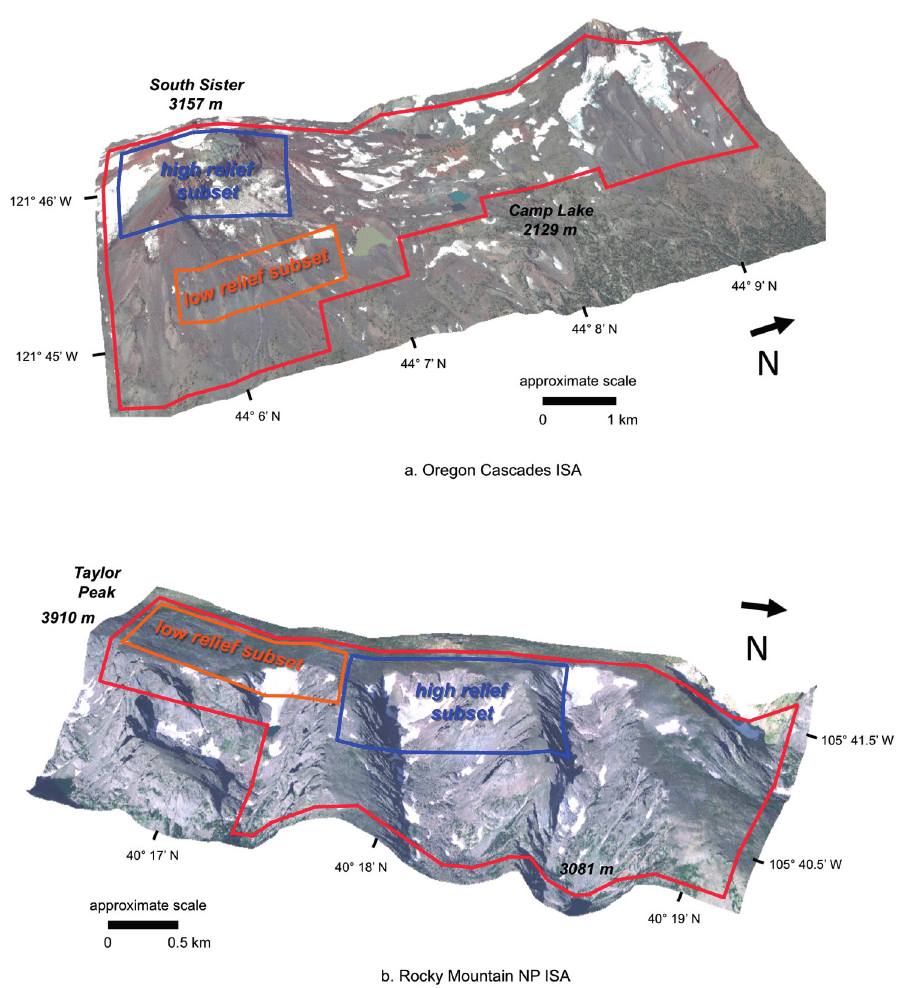
Figure 2. ( a ) Oregon Cascades ISA and ( b ) Rocky Mountain NP ISA. Extent of ISA is outlined in red, while the extent of high-relief subsets are outlined in blue and low-relief subsets are outlined in orange. Image sources: Digital elevation models for both study areas are from the National Elevation Dataset (NED) [50]. Draped imagery for the